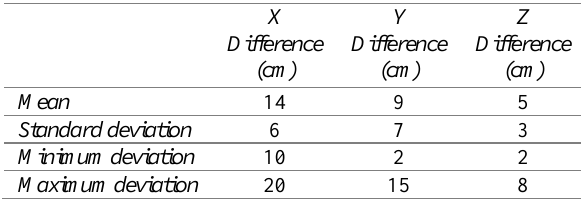
Table 1. Fusion assessment